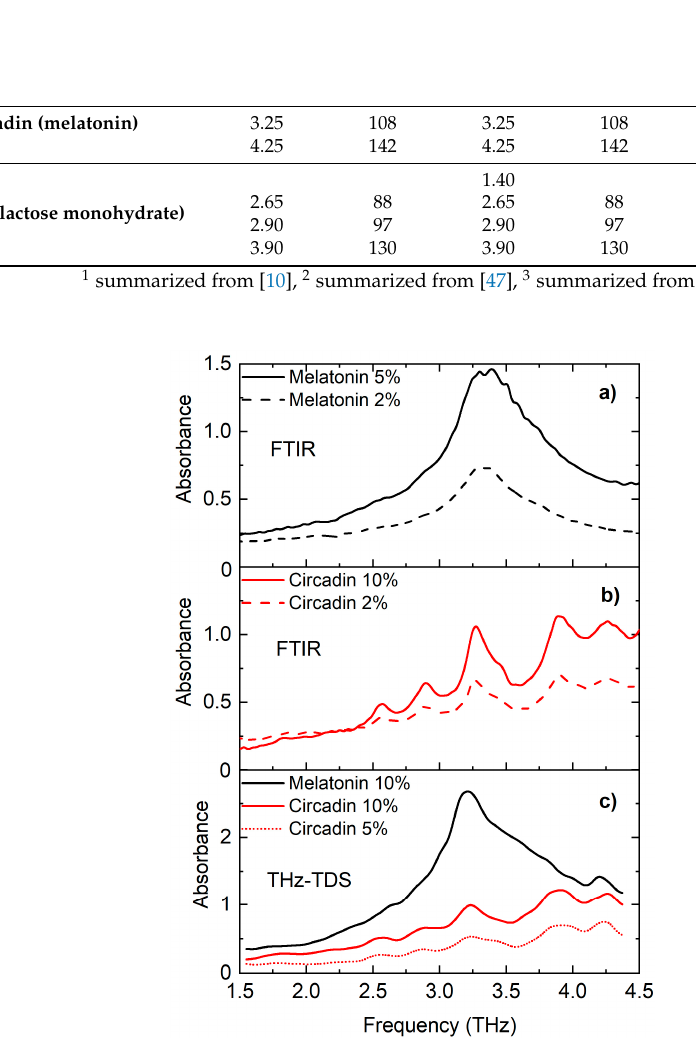
Figure 4. Concentration-dependent THz absorption spectra of ( a ) melatonin obtained by FTIR, ( b ) Circadin obtained by FTIR melatonin, and ( c ) melatonin and Circadin obtained by THz-TDS.